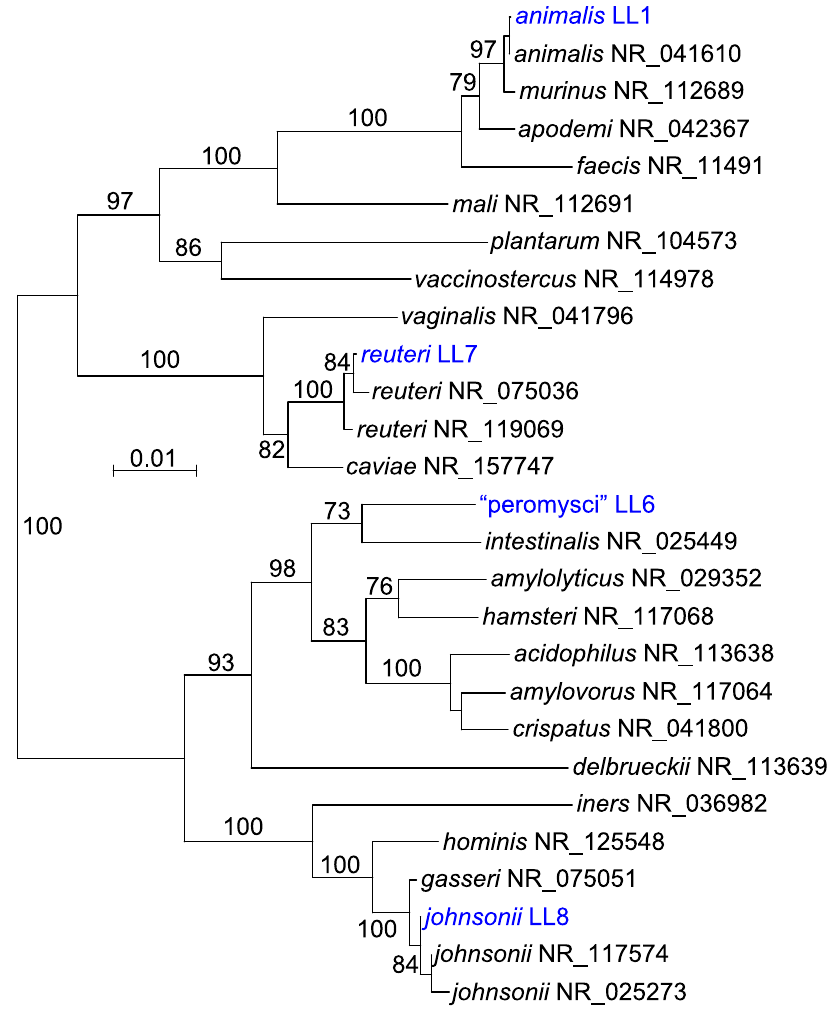
Fig 2. Neighbor-joining distance phylogram of 1420 aligned positions of 16S ribosomal RNA genes of the culture isolates of four Lactobacillus species from Peromyscus leucopus and selected other Lactobacillus spp. The sources for the accession numbers for the strains are given in Methods ( L . animalis , L . reuteri , and “L. peromysci”) or in Table 1. The other organisms represented are from Reference RNA sequences database of the National Center for Biotechnology Information; the accession numbers are given after the species name. The scale for distance by criterion of observed differences is indicated. Percent bootstrap (100 iterations) support values of � 90% at a node are